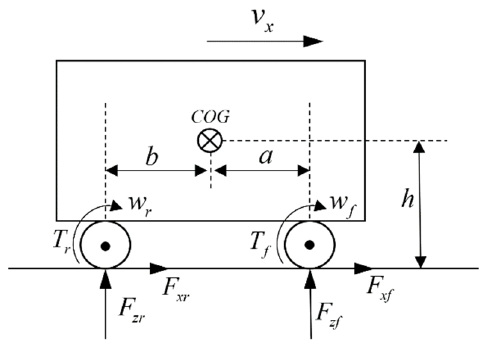
Figure 1. The vehicle model.